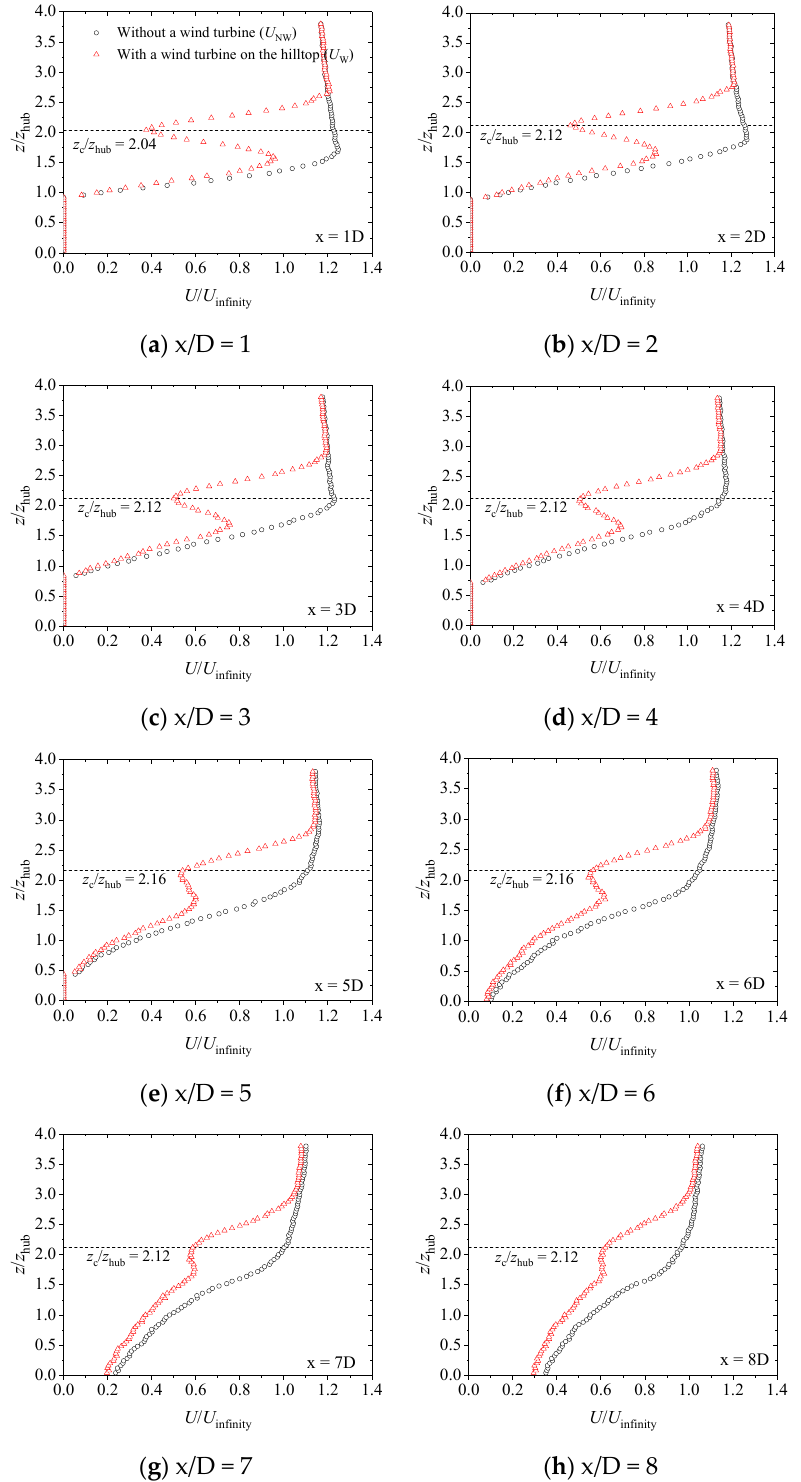
Figure 13. A detailed comparison of the wake with the wind turbine located on the hilltop (case 4, x/D = 1 to 8).